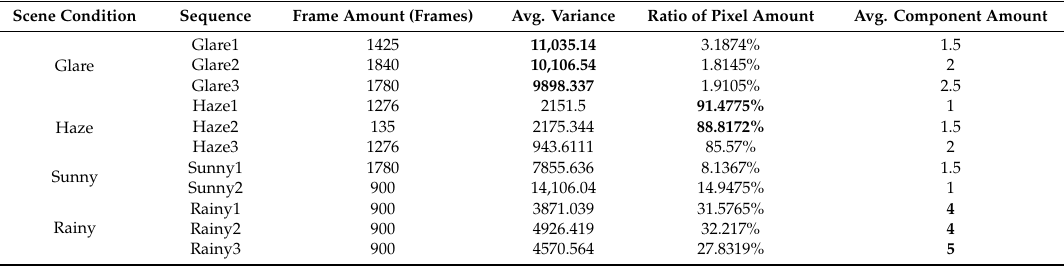
Table 2. Parameters applied on different scenarios.